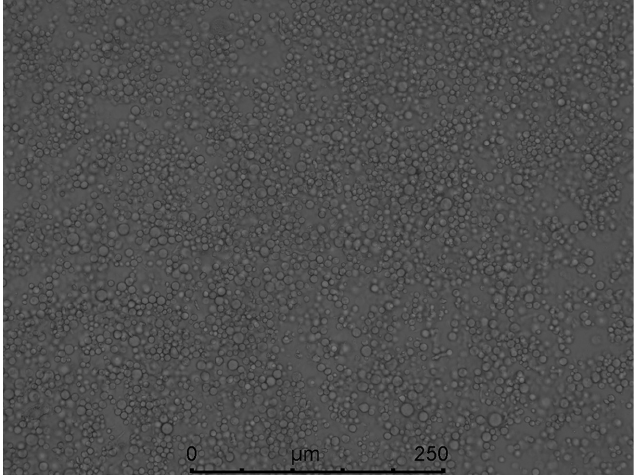
J. Fungi 2021 , 7 , x FOR PEER REVIEW Figure 8. Morphology of A. phaeospermum protoplasts under 10 × 40 power optical microscope.